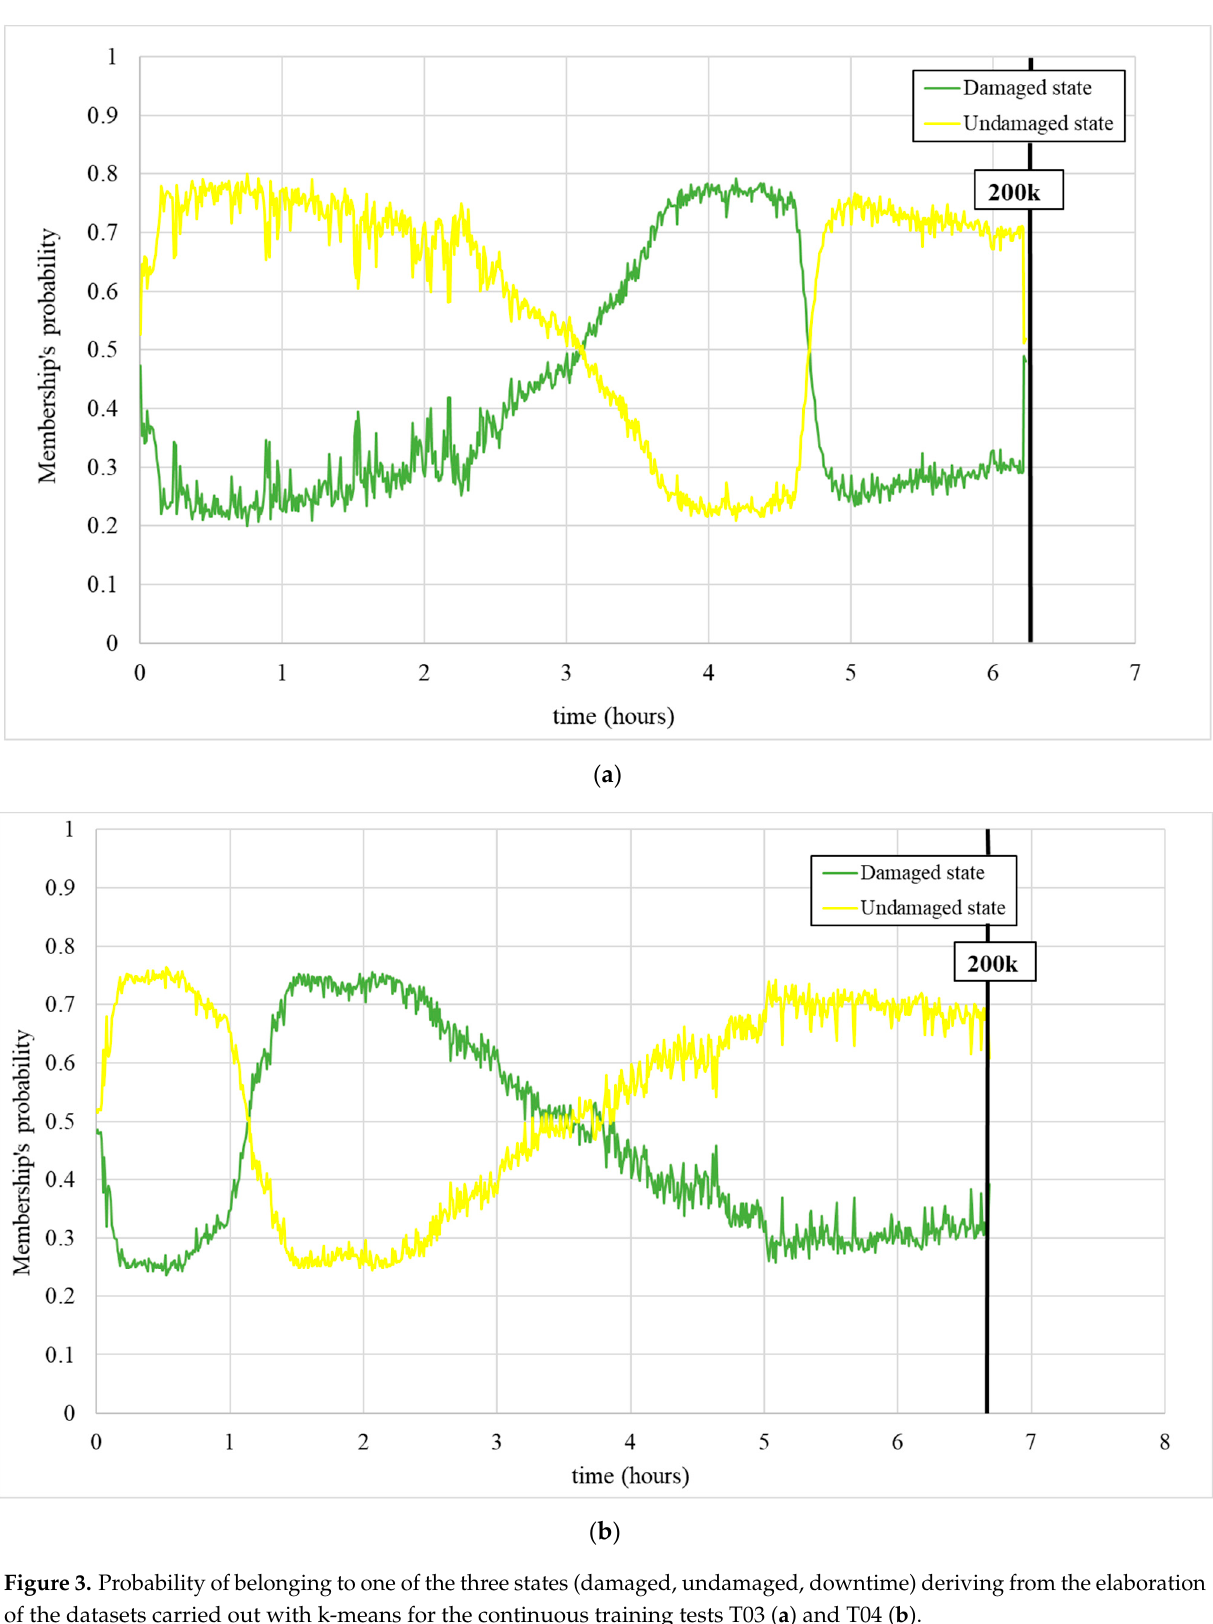
Figure 3. Probability of belonging to one of the three states (damaged, undamaged, downtime) deriving from the elaboration of the datasets carried out with k-means for the continuous training tests T03 ( a ) and T04 ( b ).